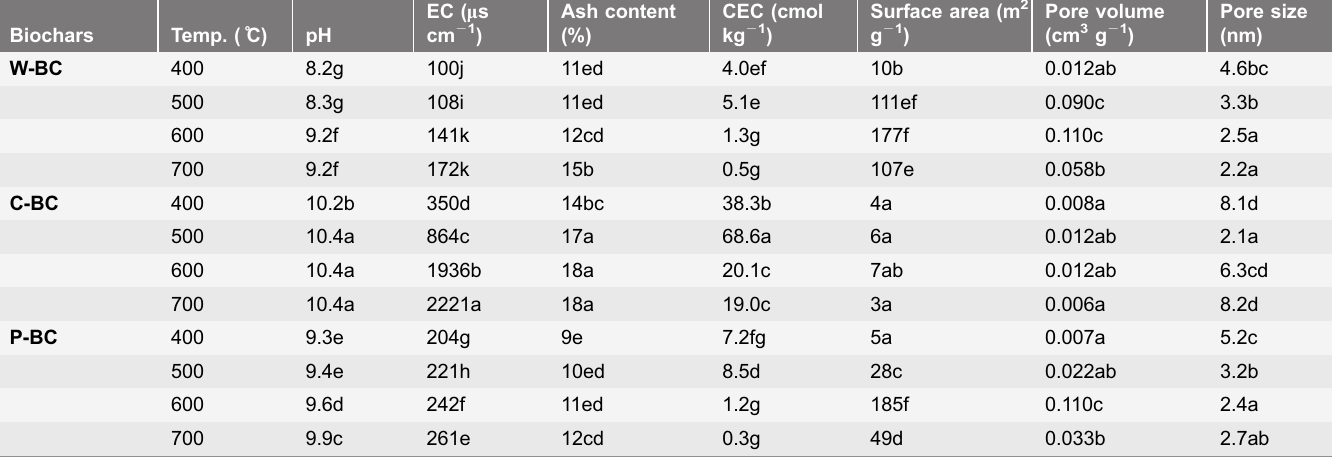
Table 2. pH values, electrical conductivity (EC), ash content, cation exchange capacity (CEC), BETsurface area, pore volume and pore size of W-BC, C-BC and P-BC at different pyrolytic